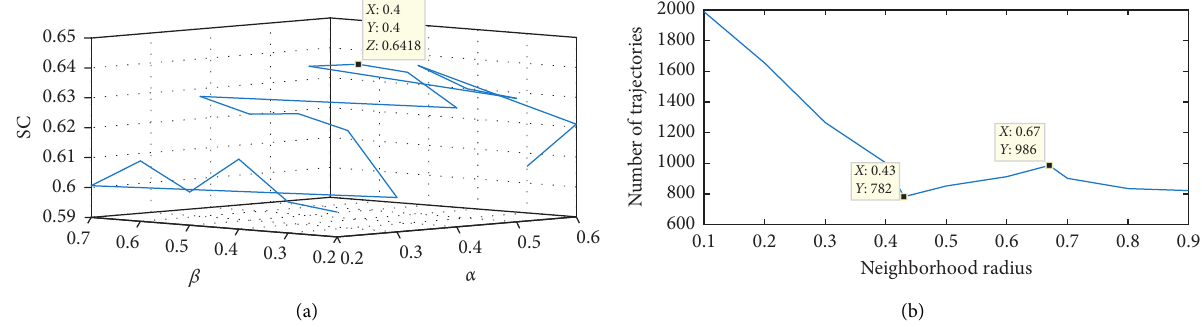
and MinTRs . min max